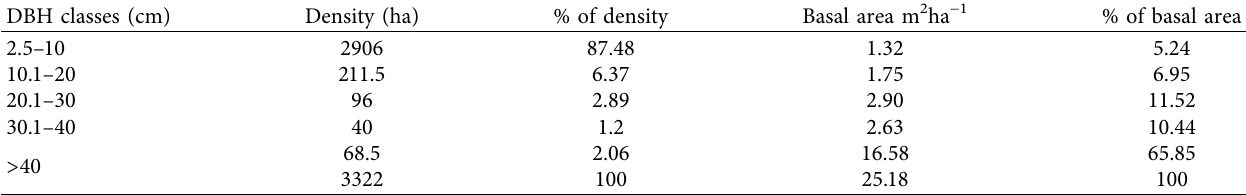
Table 5: Contribution of diferent DBH classes to the total density and basal area per hectare in Jib Godo Natural Forest. DBH classes (cm)